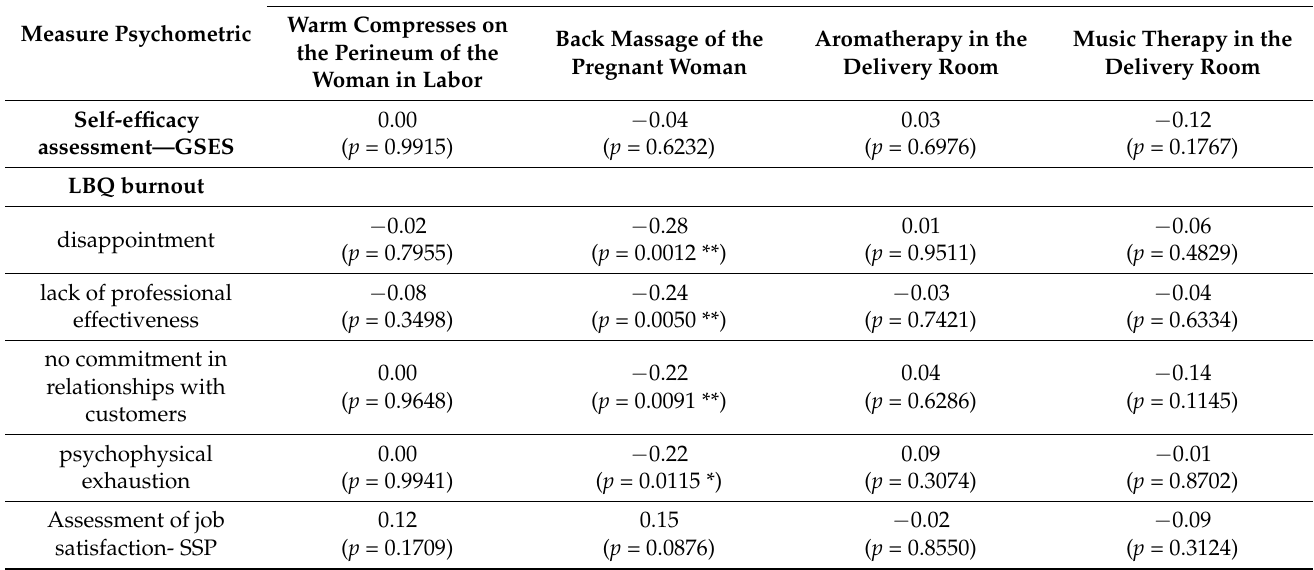
Table 6. The use of non-pharmacological methods of relieving labor pain by midwives in relation to their own effectiveness, burnout, and job